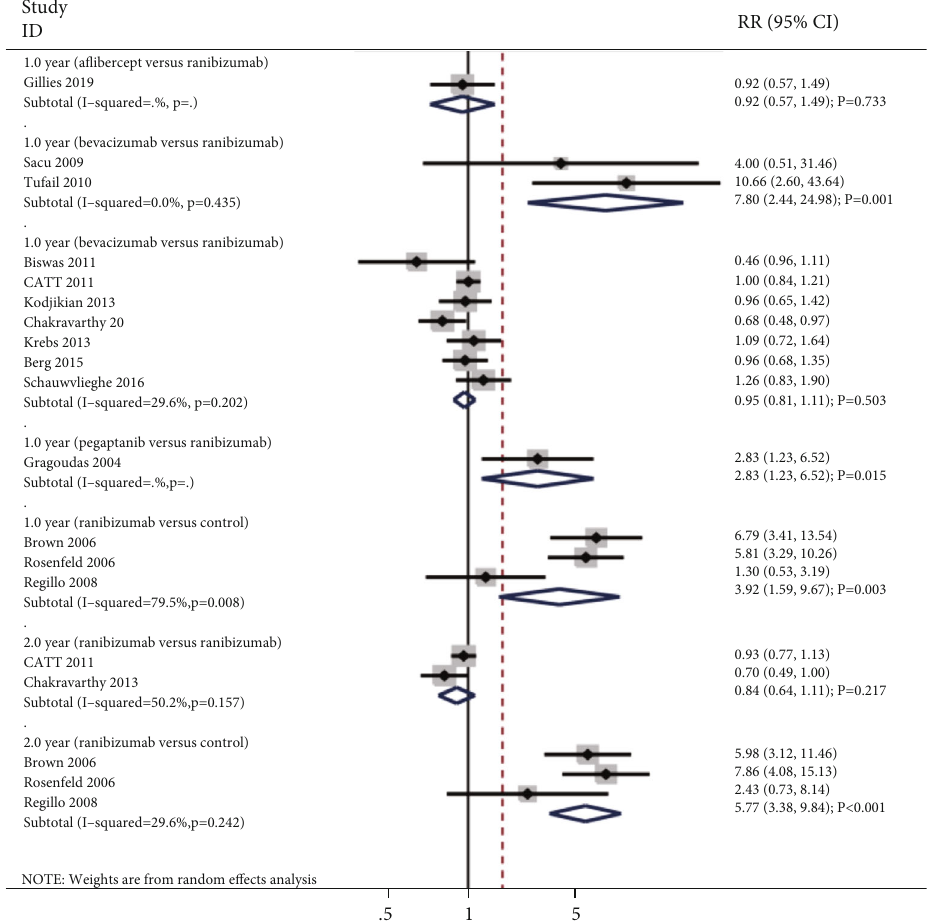
Figure 4: E ff ect of anti-VEGF inhibitors on the incidence of gain of 15 or more letter visual